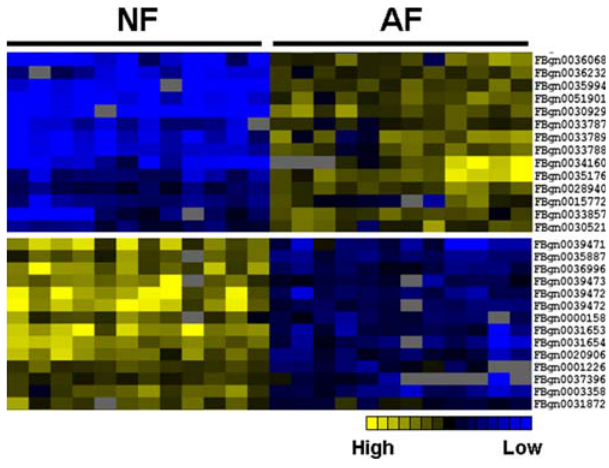
Figure 3. Distinct expression clusters between AF and NF samples revealed by microarrays. cDNA Microarray results were clustered according to the levels of expression of the hypoxia selected and the control cross adult fly samples using GeneCluster [42]. Differentially expressed genes were sharply distinguished between NF and AF flies. Upper panel: a representative subgroup of up-regulated genes. Lower panel: a representative subgroup of down-regulated genes. Yellow color represents relative high levels of expression while blue represents low levels of expression. The brightest color is 1.5-fold or greater differential from the reference black.